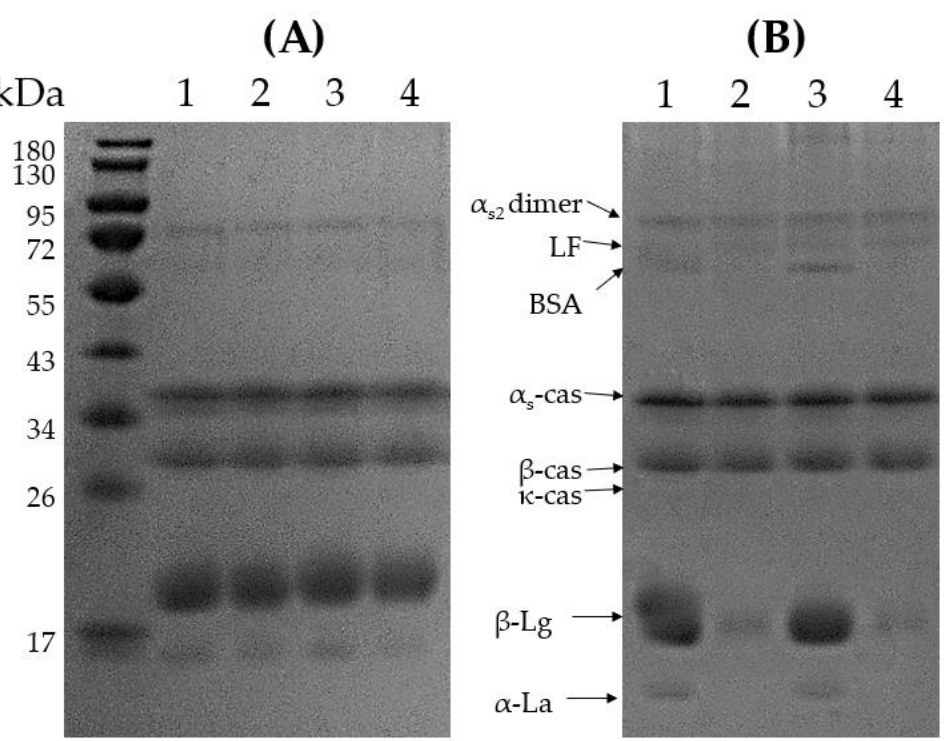
Foods 2022 , 11 , 3752 Figure 6. Reducing ( A ) and nonreducing ( B ) SDS-PAGE analysis of the IMF 50%-75 ◦ C (1), 50%-100 ◦ C (2), 60%-75 ◦ C (3), and 60%-100 ◦ C (4). LF = lactoferrin, BSA = bovine serum albumin, cas = casein, β -Lg = β -lactoglobulin, α -La = α -lactalbumin. Although the IMFs contained a higher proportion of WP, caseins predominated at the oil – water interface of all four emulsions (Figure 7). The preferential adsorption of ca- seins over whey proteins in dairy systems has been reported and explained by their higher flexibility and hydrophobicity [2,21 – 24] . α -La was not detected at the interface, while β - Lg was only detected at the interfaces of the emulsions pasteurized at 75 °C (1i and 3i). The IMFs pasteurized at 100 °C presented the lowest levels of proteins (caseins and β -Lg) adsorbed at the emulsion interface (lanes 2i and 4i). The lower protein content at the in- terface of 50%-100 °C and 60%-100 °C could be explained by the whey protein denatura- tion and whey protein – whey protein and whey protein – casein aggregation, which affects the flexibility of the proteins impairing their ability to locate at the interface [25,26].